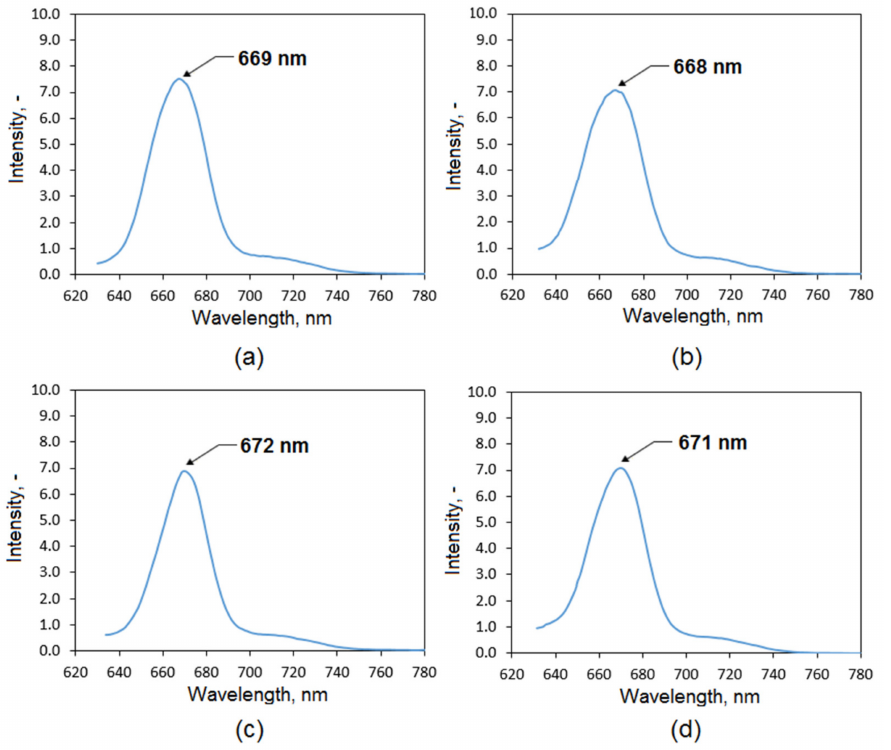
Figure 5. Fluorescence spectra of the natural extracts: ( a ) commercially available extract; ( b ) plant extract prepared using 50% ethanol solution; ( c ) plant extract prepared using 95% ethanol solution; ( d ) plant extract prepared using 95% ethanol solution and ultrasounds.